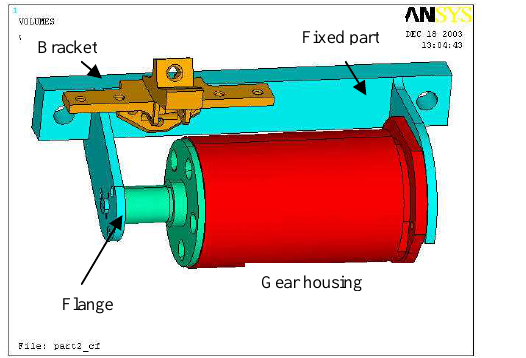
Fig. 3. Subassembly ‘A’, Fixed to Base Plate.